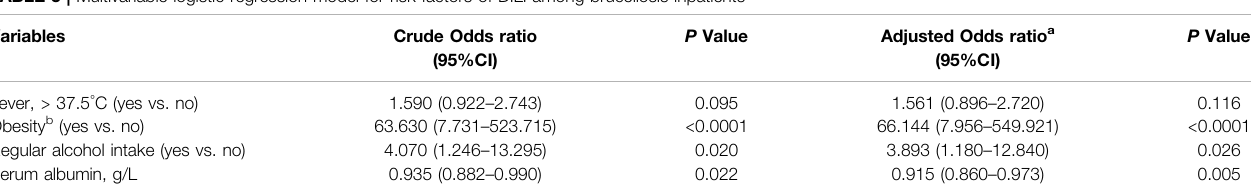
P Value P Value Adjusted Odds ratio a (95%CI) (95%CI) < 0.0001